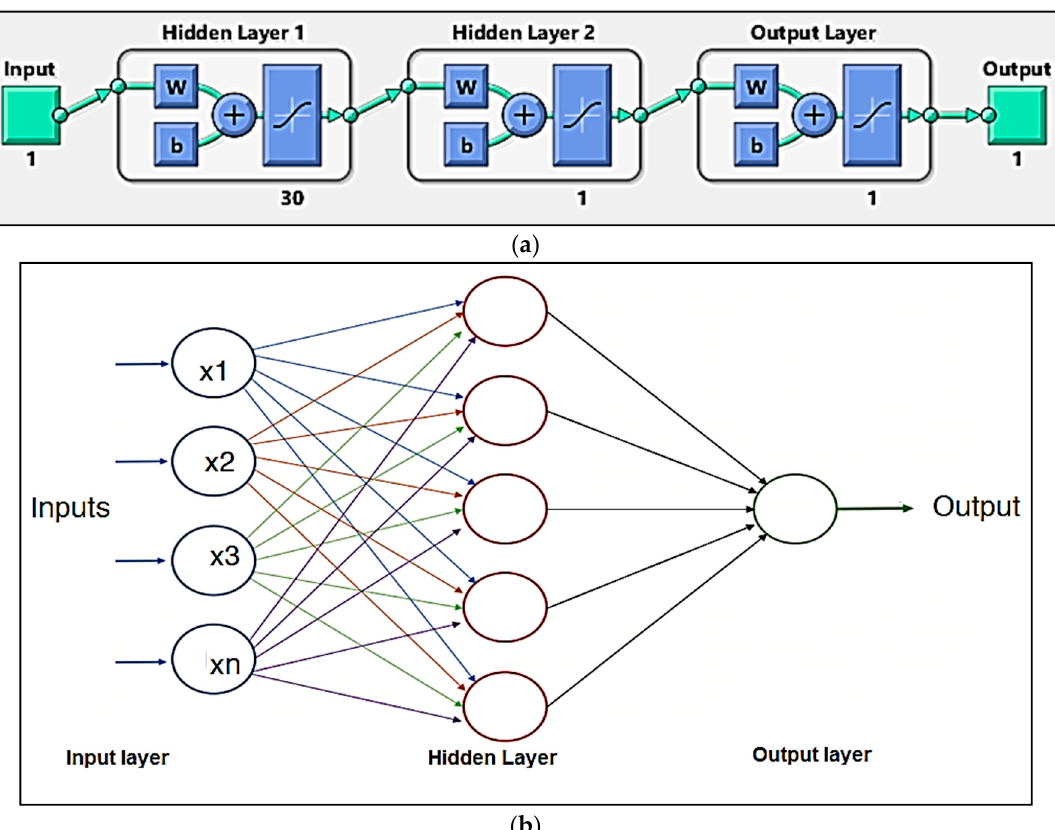
Figure 23. ( a ) Hidden layers and ( b ) ANN architecture.